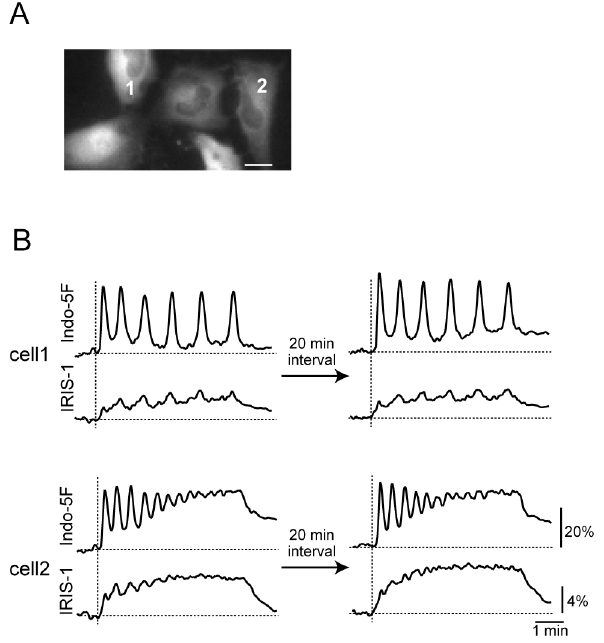
Figure 1. Reproducible cell-specific patterns in Ca 2 + and IP 3 responses in HeLa cells stimulated with histamine. (A) Venus fluorescence image of IRIS-1-expressing HeLa cells before histamine stimulation. Bar, 20 m m. (B) Changes in 460–510 nm emission of Indo-5F signals (F/F 0, where F 0 is the basal level of F; top) and ECFP/Venus emission ratio of IRIS-1 signals ( D R/R 0 ; D R was defined as R – R 0 , where R 0 is the basal level of R; bottom) after repeated additions of 3 m M histamine with a 20-min interval in two different cells within the same field of view shown in (A). The horizontal broken lines indicate the baseline levels of the IRIS-1 and Indo-5F signals. The vertical broken lines indicate the onsets of stimulation.